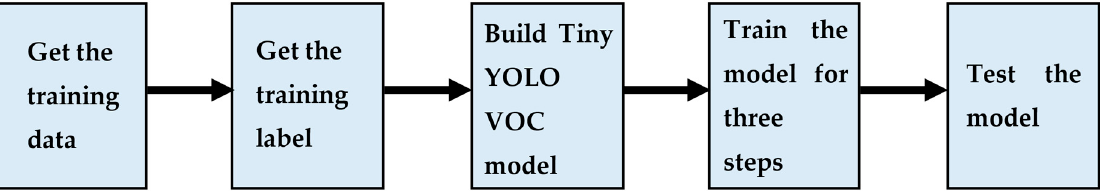
Figure 7. Steps of object detection of a car.